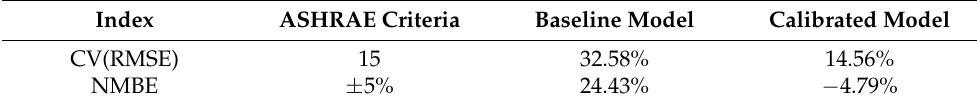
Table 3. Estimated CV(RMSE) and NMBE of the calibrated simulation model for operational energy uses.